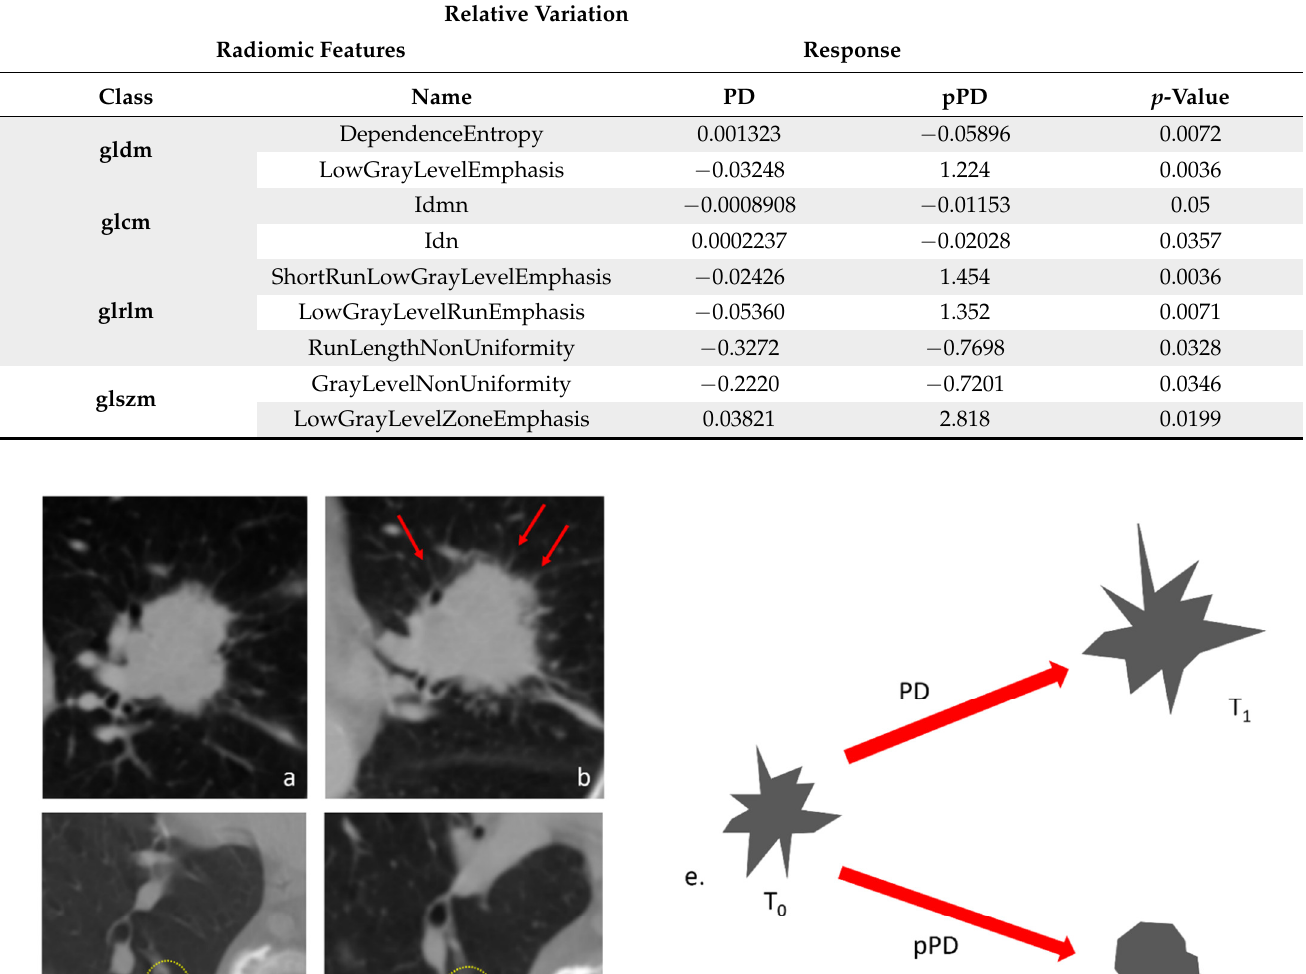
Table 2. Delta-radiomic features were calculated with the RV method that resulted statistically differ- ence in PD and pPD lesions. The results are presented as median values for each class and p -values.